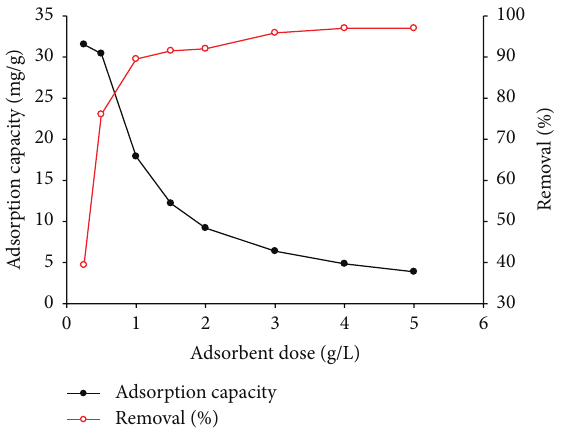
Figure 9: Effect of the adsorbent dose on the adsorption of copper by